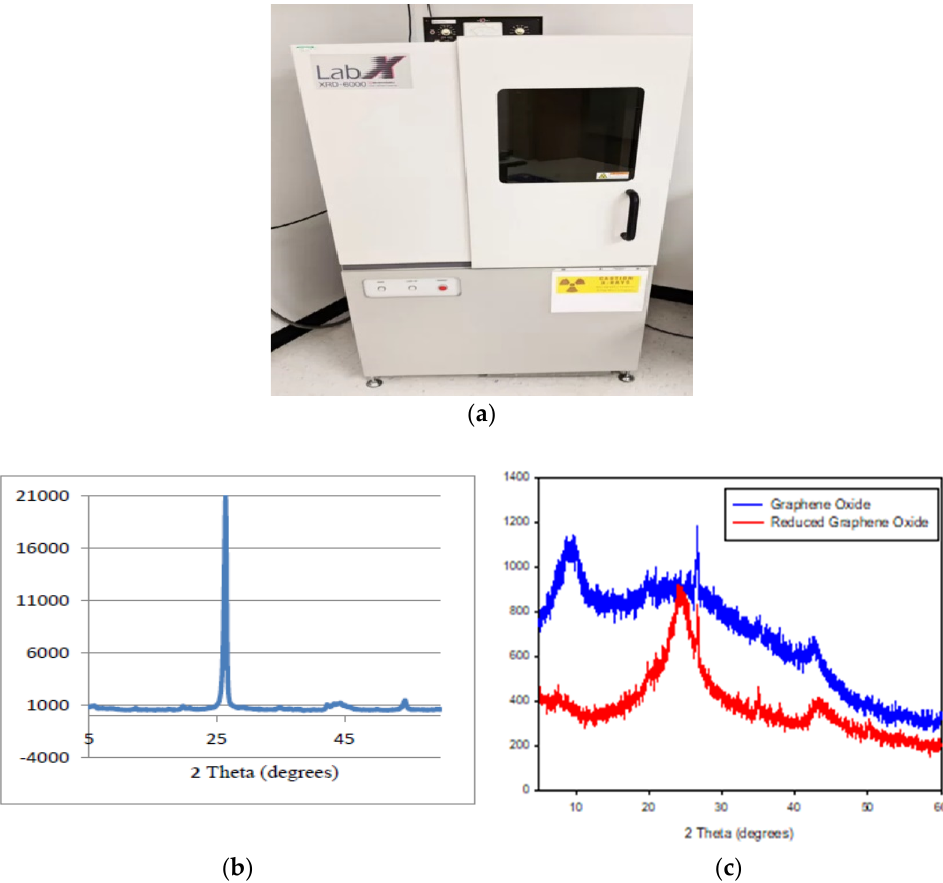
Figure 4. ( a ) X-ray Diffraction (XRD) device, XRD characterization; ( b ) pure graphite, ( c ) graphene oxide and reduced graphene oxide.